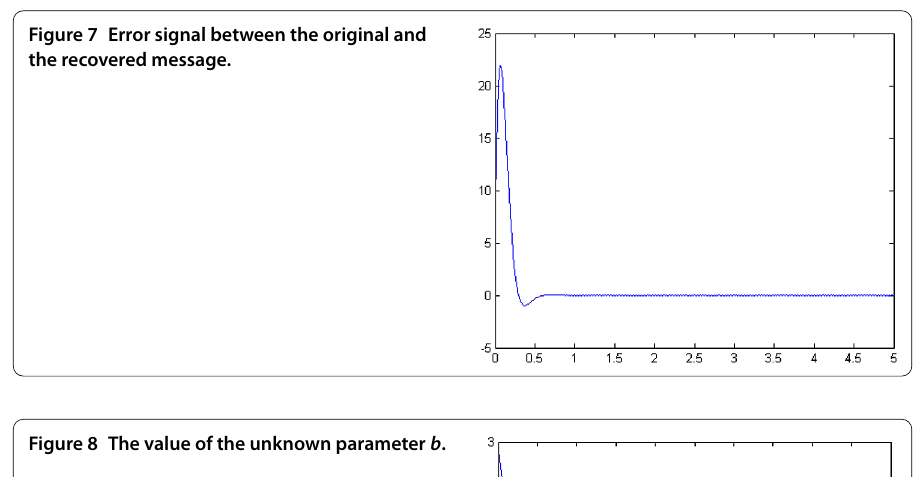
Figure 8 The value of the unknown parameter b